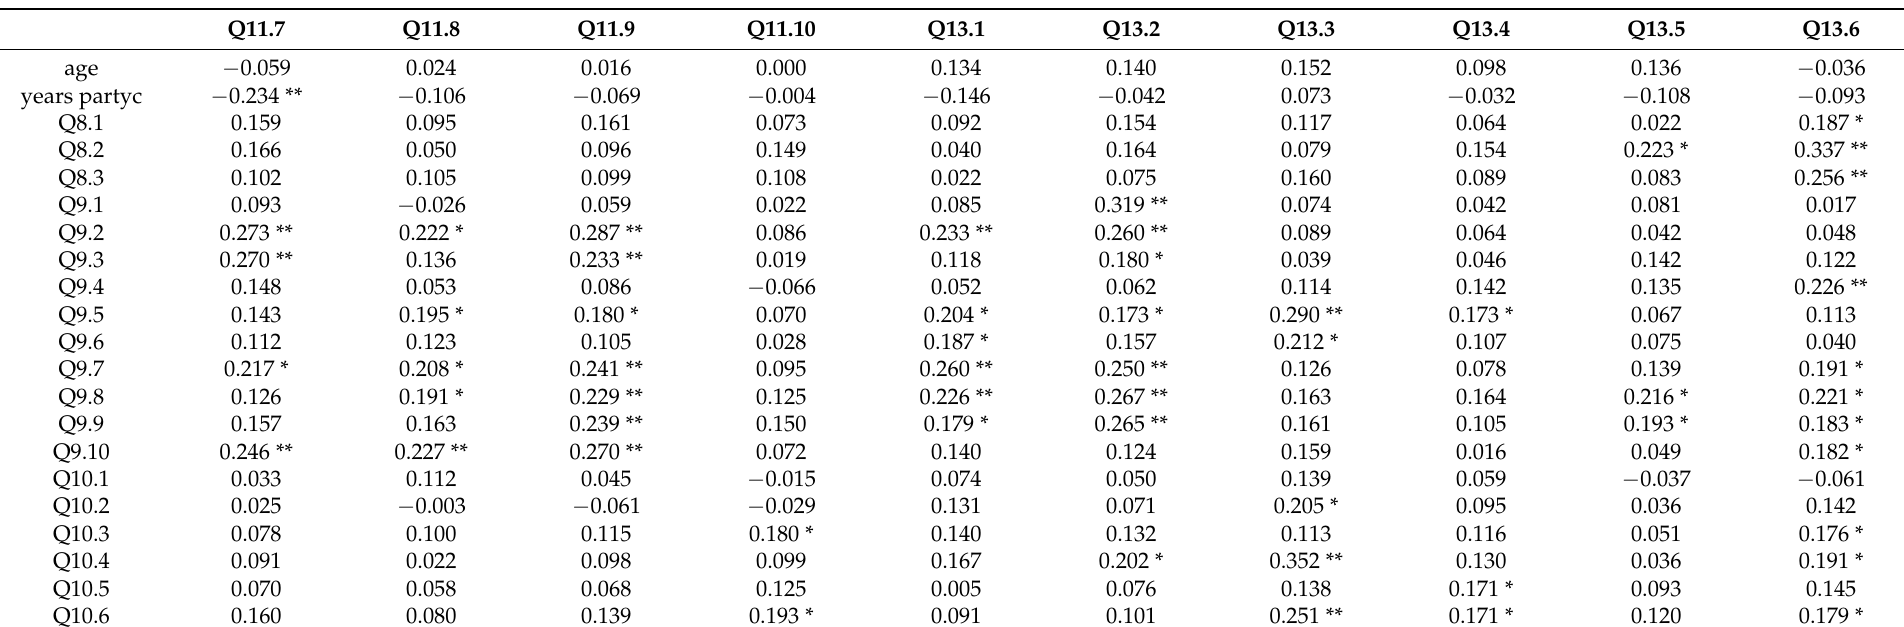
Table A3. Pearson’s correlation matrix, * significant at the alpha 0.05 level, ** significant at the alpha 0.01